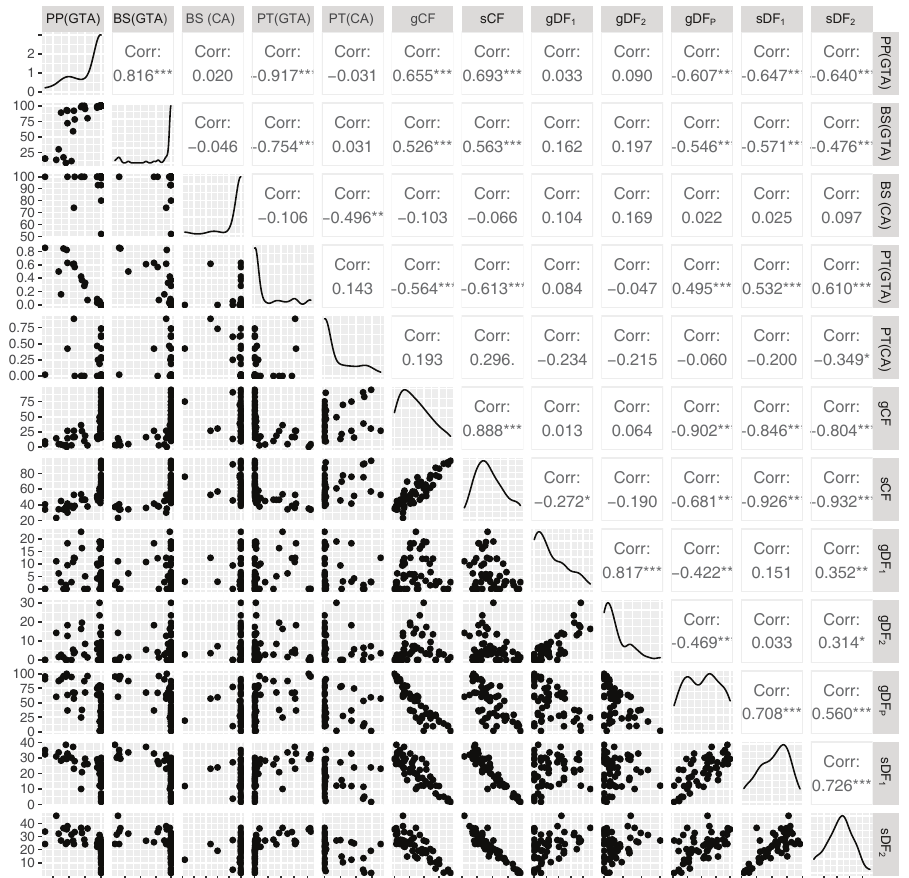
Figure 5. Scatter plots from gene discordance analysis. The graphs show the relationships between PP (gene tree analysis [GTA]), BS (GTA), BS (concatenated analysis [CA]), polytomy test [PT] (GTA), PT (PA), gene concordance factor (gCF), site concordance factor (sCF), gene discordance factors (gDF1, gDF2), gene discordance factor (P stands for paraphyly) (gDFP) and site discordance factors (sDF1, sDF2). The strength and direction of correlations (r) between variables are described as follows: r = -1, perfect negative relationship; -1 < r ≤ -0.70, strong negative relationship; -0.70 < r ≤ -0.50, moderate negative relationship; -0.50 < r ≤ -0.30, weak negative relationship; -0.30 < r < 0.30, no relationship; 0.30≥ r < 0.50, weak positive relationship; 0.50 ≥ r < 0.70, moderate positive relationship; 0.70 ≥ r < 1, strong positive relationship; r = 1, perfect positive